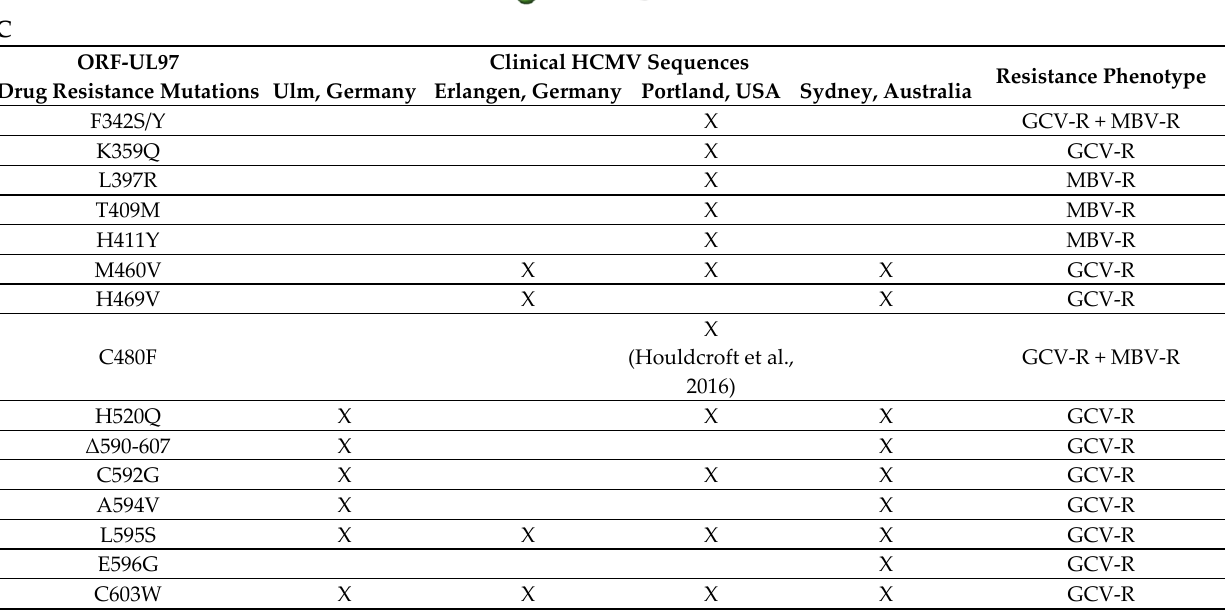
Figure 1. Overview of identified and previously known drug resistance mutations in ORF-UL97. ( A ) HCMV ORF-UL97 drug resistance mutations detected in clinical specimens or cell culture. A schematic map shows resistance-conferring mutations in the globular domain (amino acids 337-707) that were analyzed in this study [16]. The resistance phenotype is color-marked. ( B ) Predicted structural allocation of pUL97 drug resistance mutations. The location of drug resistance